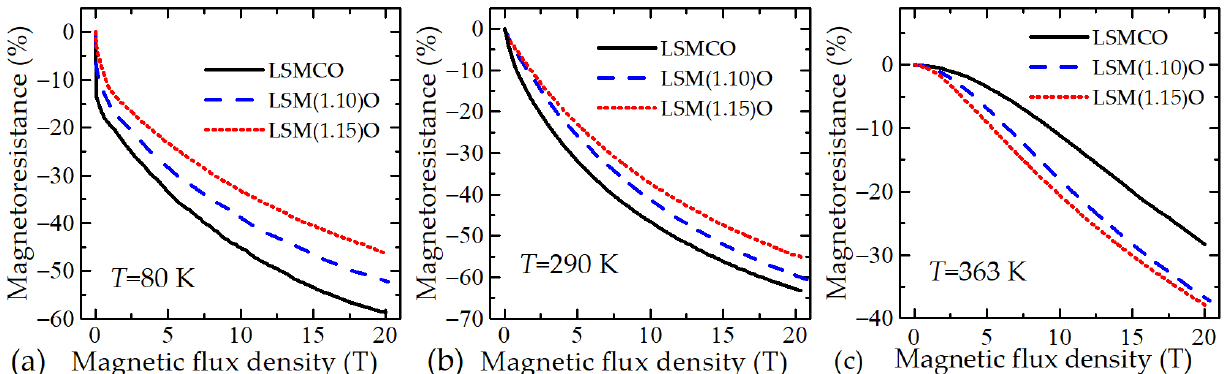
Figure 3. MR dependences on magnetic flux density for films with different Mn and Co contents at various ambient temperatures: ( a ) 80 K, ( b ) 290 K, ( c ) 363 K.